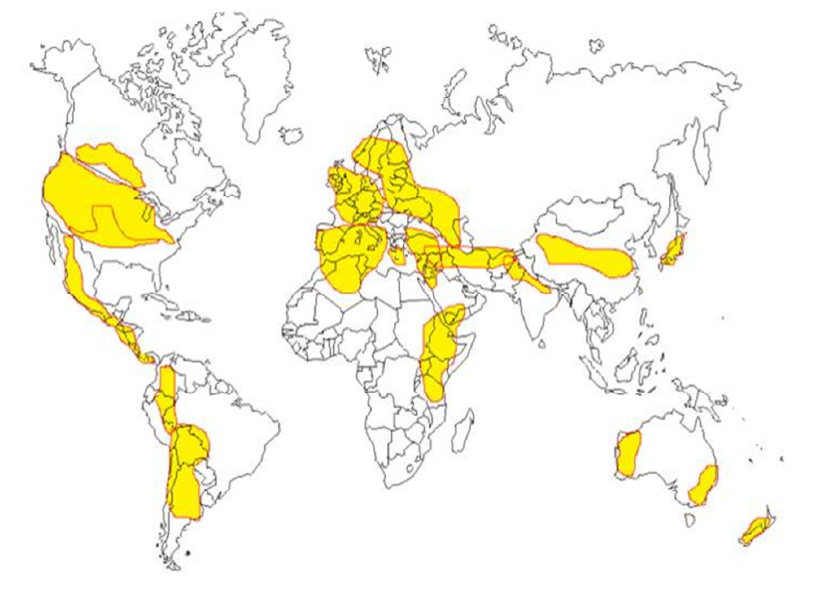
Fig. 5. Worldwide geographical distribution of stripe rust (Brar,